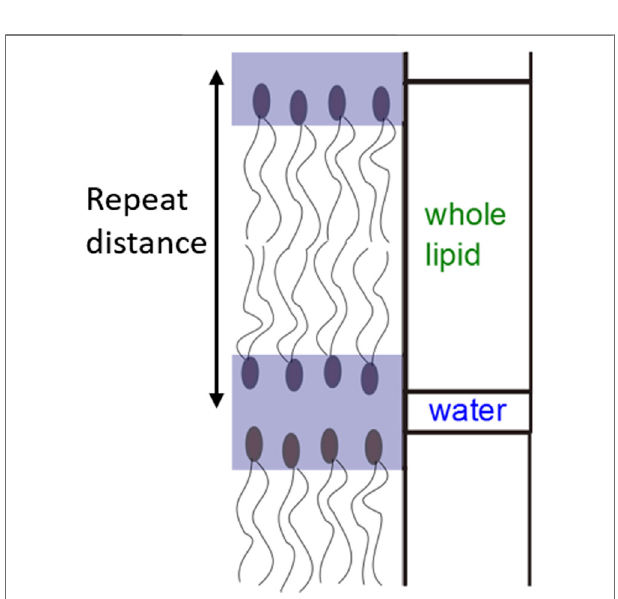
FIGURE 2 | Schematic depicting the repeat distance and how the layer model for neutron re fl ectivity fi tting was de fi ned.